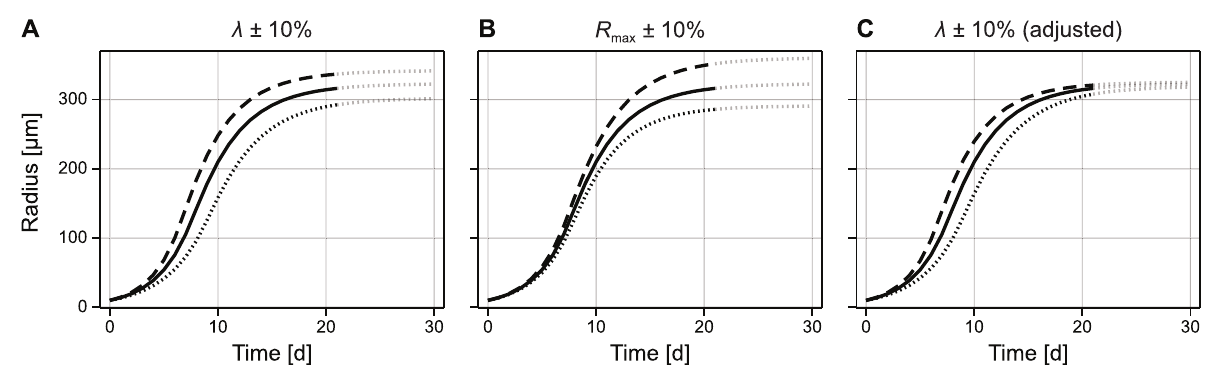
Fig 8. Using the sensitivity matrix of the model-map to achieve relative changes in model features. We apply the rows in the sensitivity matrix to adjust the parameters in the Ward and King model to achieve approximate relative changes in the parameters in the logistic model. In (A–B) we move in the direction of each row of the corresponding row of the sensitivity matrix; in (C) we move in direction of a projection of row 1 orthogonal to row 2, resulting in relative changes to the volumetric growth rate, but not to maximum spheroid radius.